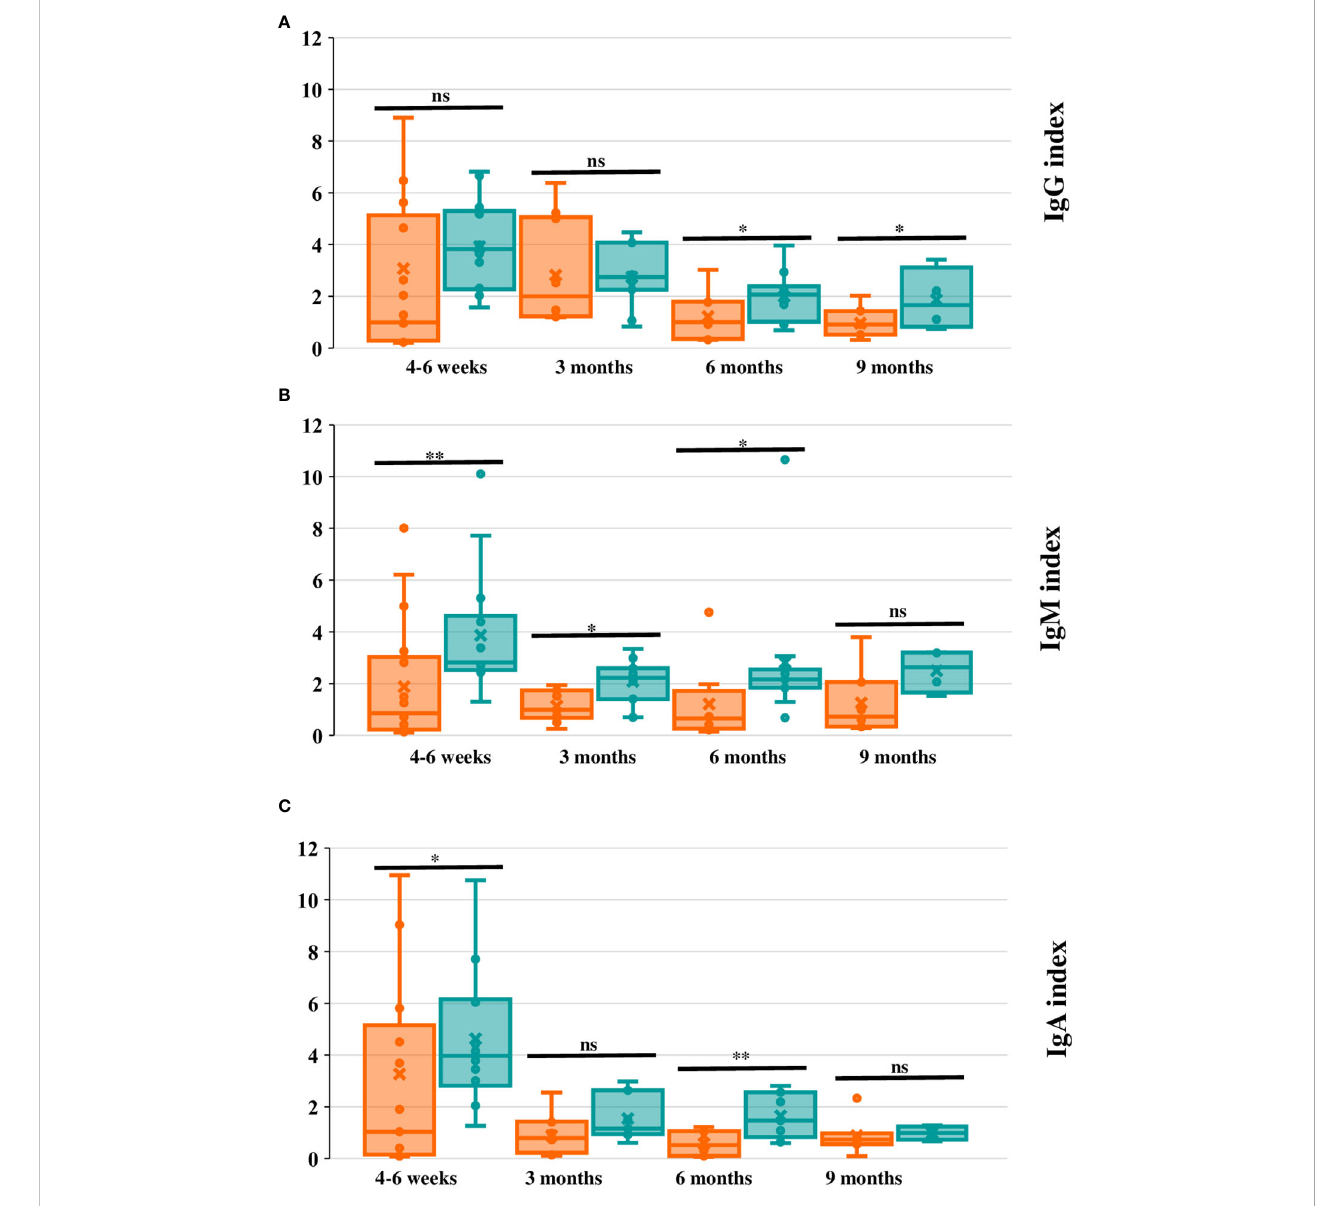
FIGURE 4 Ig index evolution in cases and controls during the long-term phase post-infection. (A-C) . IgG, IgM, and IgA index respectively (measured with Luminex assay) in cases (orange) and controls (green) at 4-6 weeks, and 3, 6 and 9 months after SARS-CoV-2 infection. The box horizontal middle line represents the median, the extremes represent lower quartile (Q1) and higher quartile (Q3); maximum and minimum values (without outliers) are represented by the horizontal lines in the extremes of the whiskers. The individual values between quartile 1 and 3 are represented by dots; the mean is represented by an “ x ” symbol. For all panels signi fi cance levels are marked as * p ≤ 0.05, **p ≤ 0.01, ***p ≤ 0.001, ****p ≤ 0.0001, ns: p>0.05. In (A) (IgG index) there is an extreme value that has not been represented at 4-6 weeks for P9, (IgG index 16.7). In (C) (IgA index) there is an extreme value that has not been represented at 4-6 months after the infection (P24, hypoxemic pneumonia; IgA index